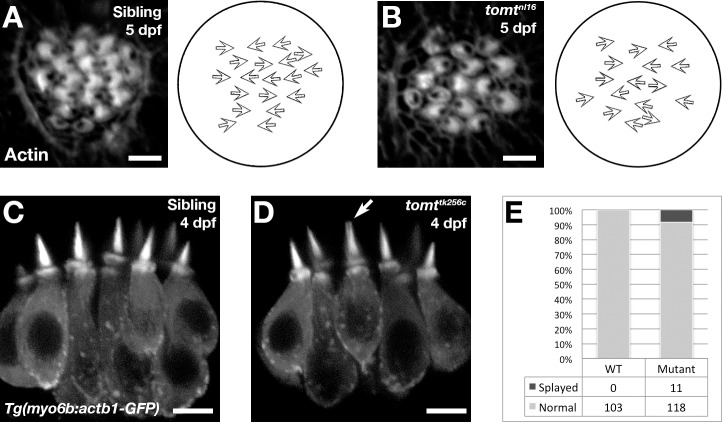
Hair bundle polarity and morphology in Tomt-deficient hair cells.(A, B) Hair cell planar polarity in neuromasts of mercury mutants. Images of hair bundles from 5 dpf wild-type sibling (B) and tomtnl16 mutant (C) larvae stained with phalloidin-488 for F-Actin. Accompanying each image is a diagram of the planar polarity of each hair bundle. (C–E) Inner ear hair cell morphology in mercury mutants. (C, D) Representative images of hair cells in lateral cristae expressing βactin-GFP from Tg(myo6b:actb1-GFP) wild-type siblings (D) and tomttk256c mutants (E) at 4 dpf. White arrow indicates a splayed hair bundle sometimes observed in mercury mutants. (E) Quantification of the splayed bundle phenotype in wild-type siblings (n = 6 larvae, 103 lateral crista hair bundles), and tomttk256c mutants (n = 8 larvae, 129 lateral crista hair bundles). Scale bars = 3 µm in B and C, 5 µm in D and E.